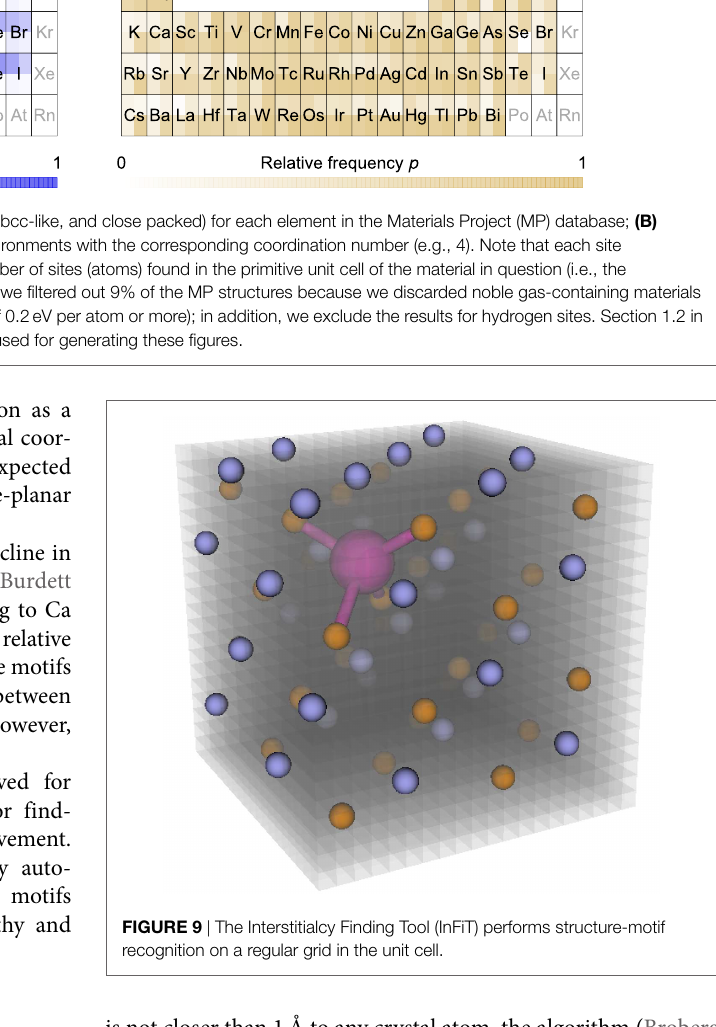
is not closer than 1 Å to any crystal atom, the algorithm